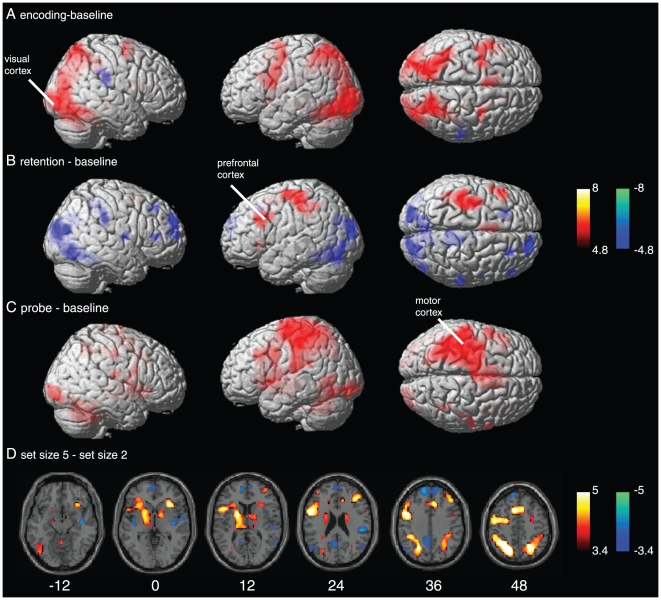
BOLD activation evoked by each task phase (encoding (A), retention (B), and retrieval (C)) contrasted against baseline (family-wise error corrected, p<0.05, red-yellow colour code).Activity for each phase is averaged across set size 2 and 5. Negative BOLD activations (i.e., ‘baseline - encoding’) are shown in a blue-green colour code. (D) BOLD activations for the contrast ‘ss5–ss2’ (red-yellow colour code) and ‘ss2–ss5’ (blue-green colour code). Activations are presented at p<0.005 (corrected for multiple comparisons using the FDR). Numbers indicate z-coordinates in MNI space.